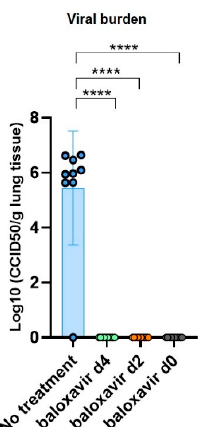
Figure 3. Baloxavir marboxil has an effective viricidal activity against influenza. Viral burden: graph representing the log 10 CCID50 per gram lung tissue receiving no baloxavir marboxil (sham, blue, n = 10 mice), baloxavir marboxil treatment-onset from day 4 (green, n = 10 mice), baloxavir treatment- onset from day 2 (orange, n = 10 mice) and baloxavir marboxil treatment-onset from day 0 (grey, n = 10 mice). Differences were considered significant if p was smaller or equal to 0.05. **** p < 0.0001. Data are represented as individual data-points, mean ± SD.